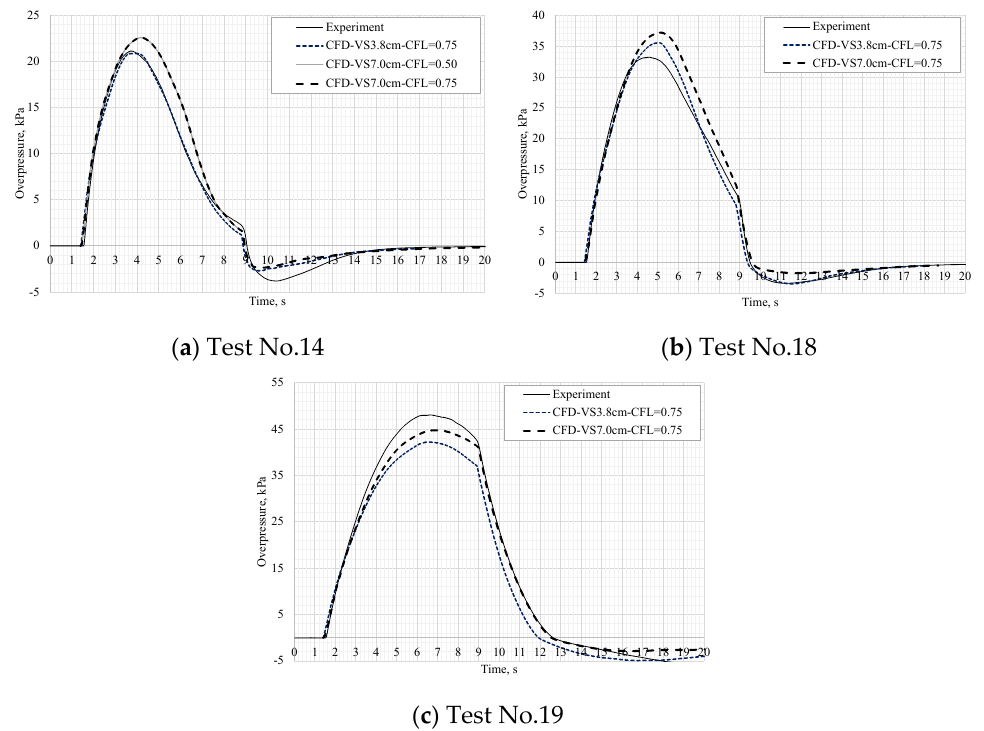
Figure 8. Pressure dynamics in the enclosure for the unified “cube grid” approach (VS7.0 cm): ( a ) Test No.14 ( 𝑃 (cid:3020) = 11.78 MPa, 𝑚(cid:4662) = 11.37 g/s, Number of vents = 3); ( b ) Test No.18 ( 𝑃 (cid:3020) = 12.46 MPa, 𝑚 (cid:4662) = 11.47 g/s, Number of vents = 2); ( c ) Test No.19 ( 𝑃 (cid:3020) = 8.93 MPa, 𝑚 (cid:4662) = 8.62 g/s, Number of vents = 1).